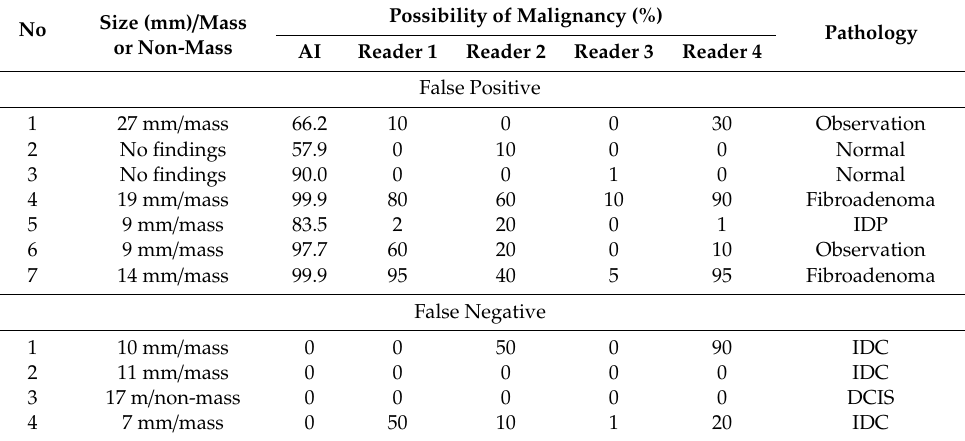
Table 5. Pathological features of false-positive and false-negative cases diagnosed by